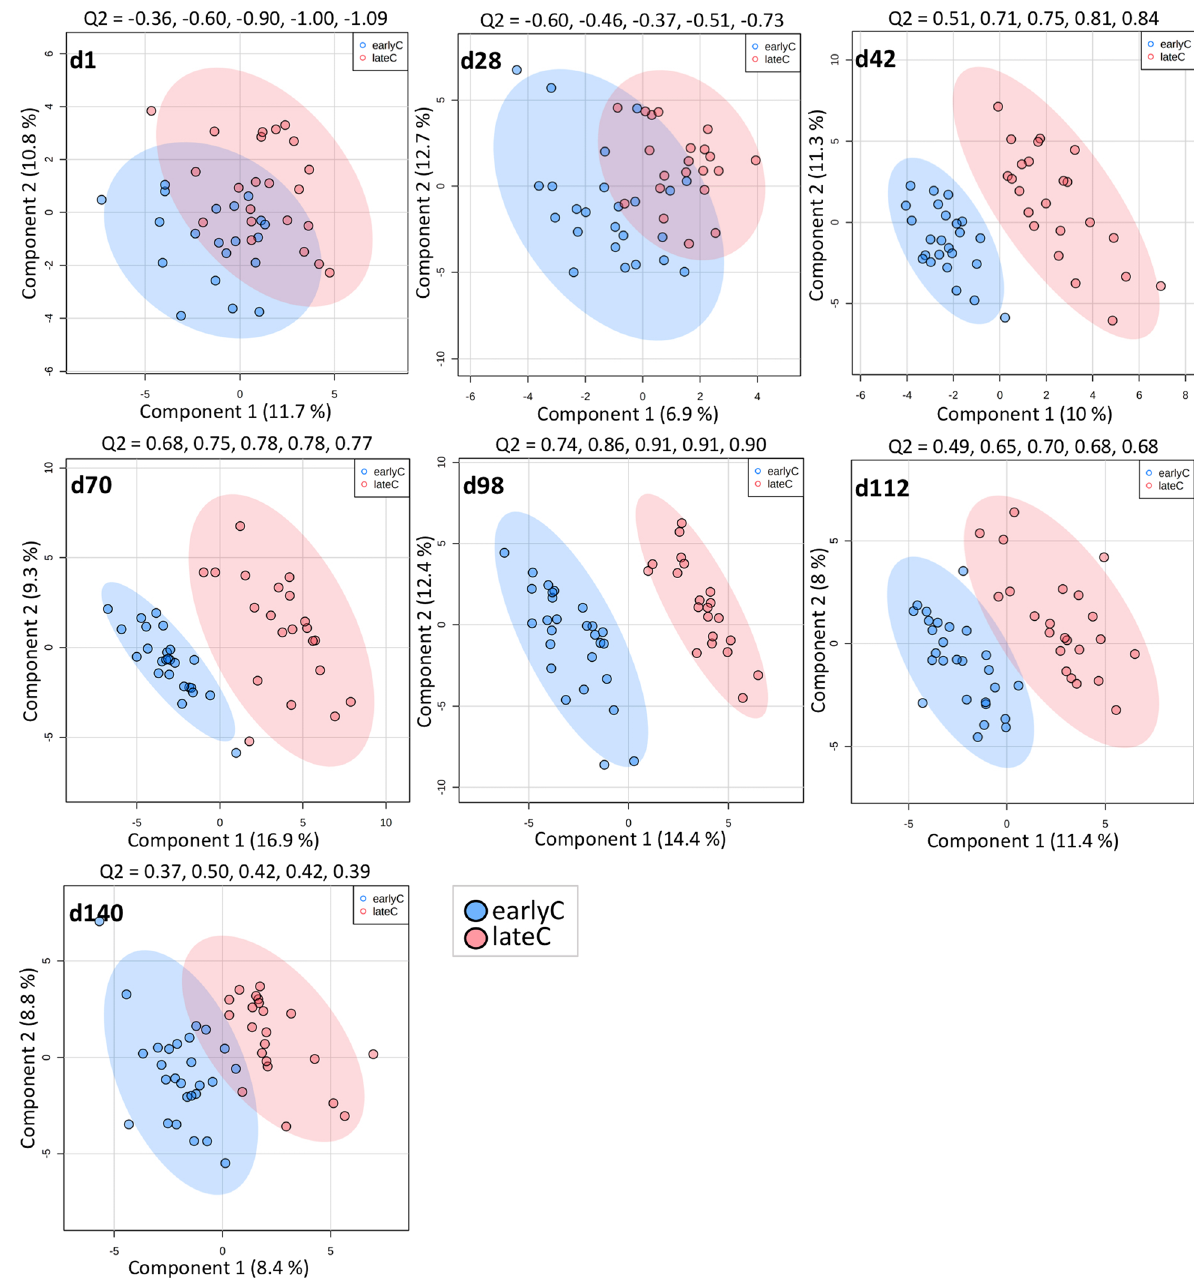
Fig. 5 Partial least squares‑discriminate analysis for identification of metabolic differences among weaning groups. Each circle indicates one sample and ellipse indicating the 95% confidence region. The quality of the models was assessed using Q2 as performance measure and tenfold cross‑validation method. The Q2 values for the first 5 components are